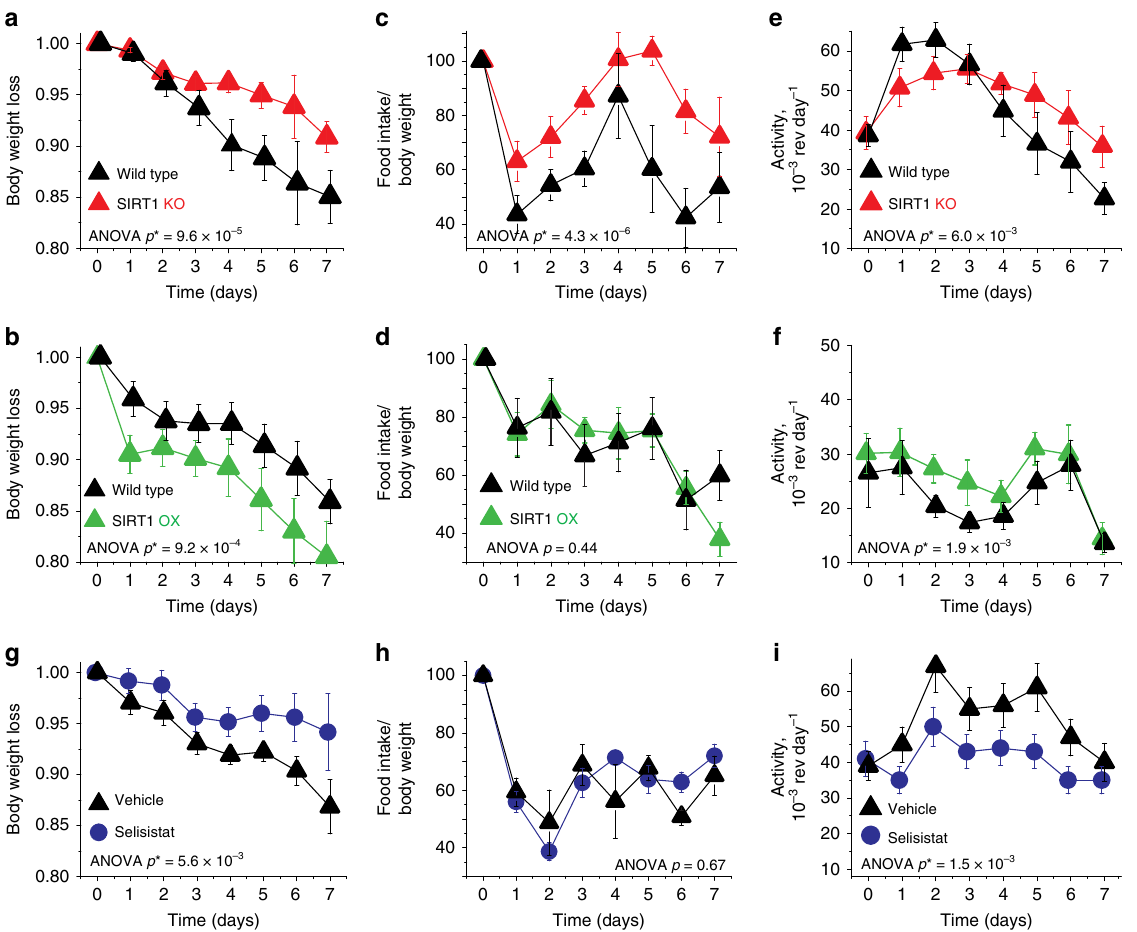
Fig. 2 SIRT1 activity ampli fi es AN-like phenotypes in animals. a BSKO mice (red) subjected to ABA are resistant to the model and lose weight slower compare to their WT littermates (black). Weight loss in fraction of initial body weight over time is presented. b BSOX mice (green) are more susceptible to ABA and showed faster weight loss. c The BSKO mice show protection from the decline in food intake typically observed during the ABA model. d BSOX mice show no difference in food intake compared to their WT littermates. e The BSKO mice also do not upregulate their activity as much as their WT littermates. f The BSOX mice have an elevated physical activity throughout the ABA model. g Selisistat-treated mice (blue), similarly to the BSKO mice, show protection from body weight loss throughout the ABA experiment. h Selisistat-treated mice consume roughly similar amounts of food during ABA. i Mice treated with selisistat do not upregulate physical activity during ABA. Statistical analysis was completed using two-way ANOVA with SEM error bars. n = 6 for the BSKO and BSOX mice and their WT littermates. n = 6 for the vehicle control and n = 7 for the selisistat-treated mice. Source data are provided as a Source Data fi